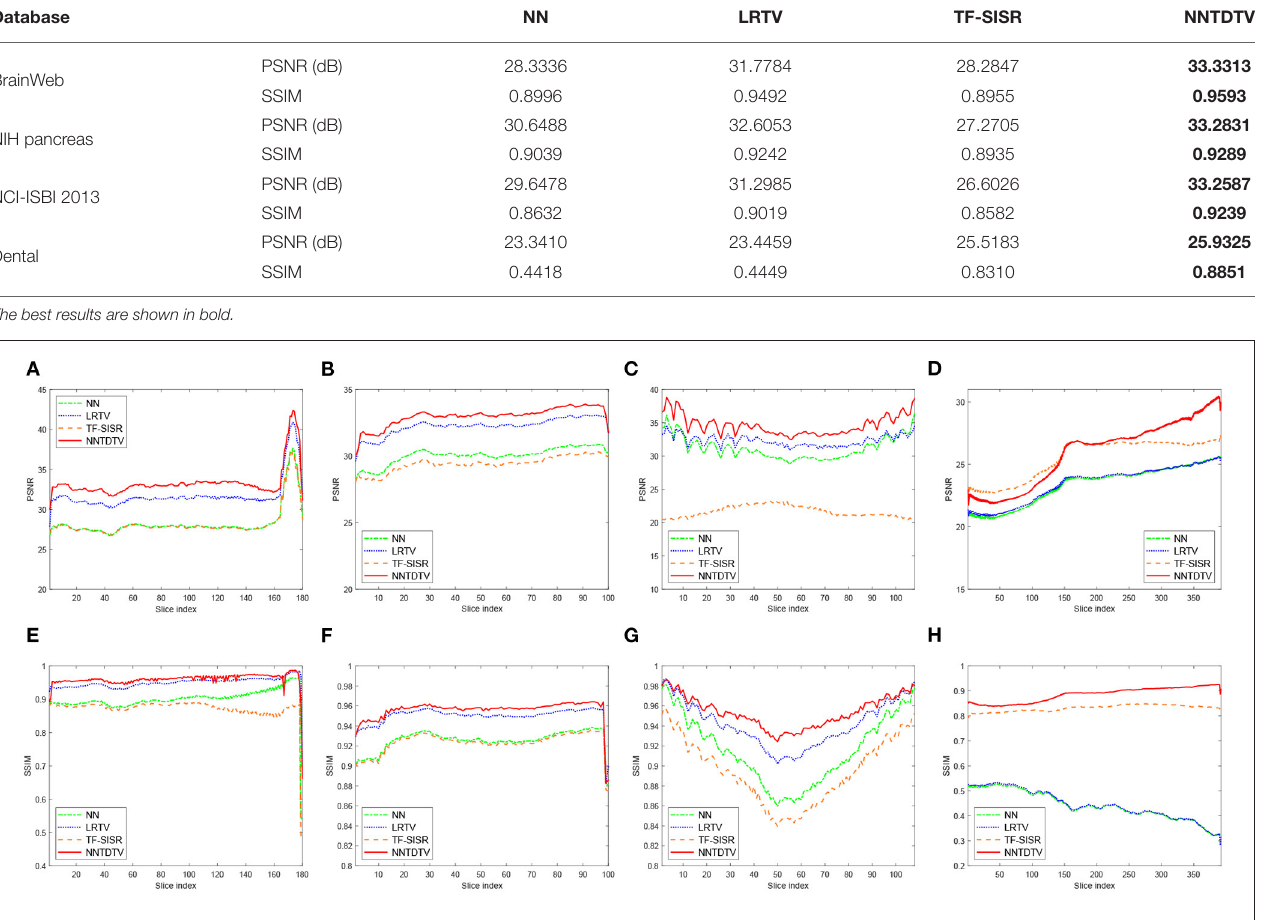
FIGURE 3 | Detailed quantitative evaluation (PSNR and SSIM) of different methods for each slice: (A,E) The Brainweb database; (B,F) the NIH pancreas segmentation database; (C,G) the NCI-ISBI 2013 database; and (D,H) the dental image.